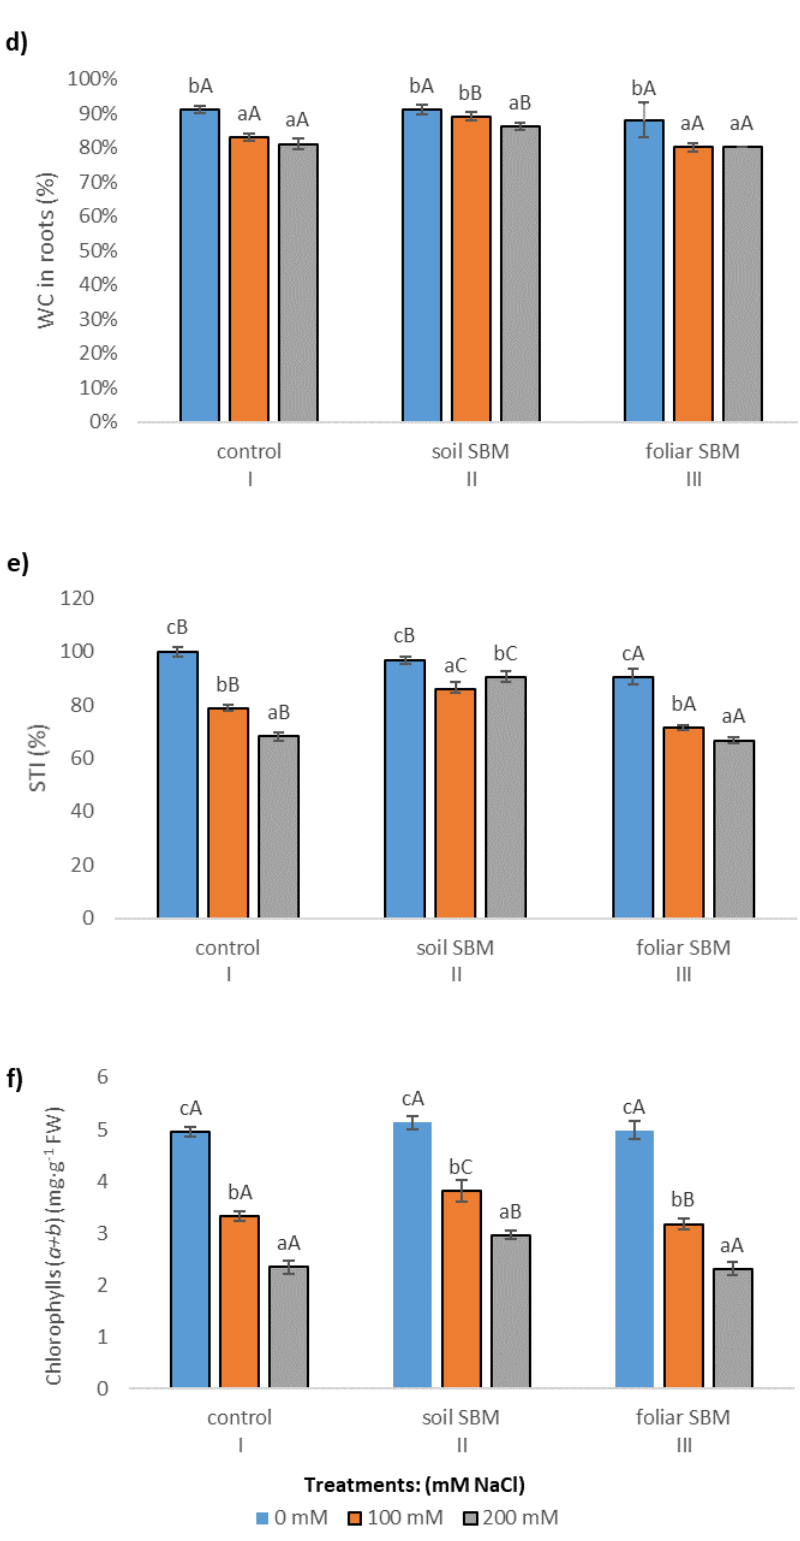
Figure 1. Stem length reduction (%) ( a ); roots length—( b ); water content in leaves (%)—( c ); water content in roots (%)—( d ); stress tolerance index (STI)—( e ); total chlorophylls (Chl a + b ) ( f ) in the Thymus serpyllum plants after five weeks of salt stress and sugar beet molasses treatments (soil SBM—sugar beet molasses applied to the soil; foliar SBM—shoot application of sugar beet molasses). Stem length is shown as percentages of the corresponding non-stressed controls, taken in each case as 100%. Values shown are means ± SD (n = 7). For each variant of the experiment, lowercase